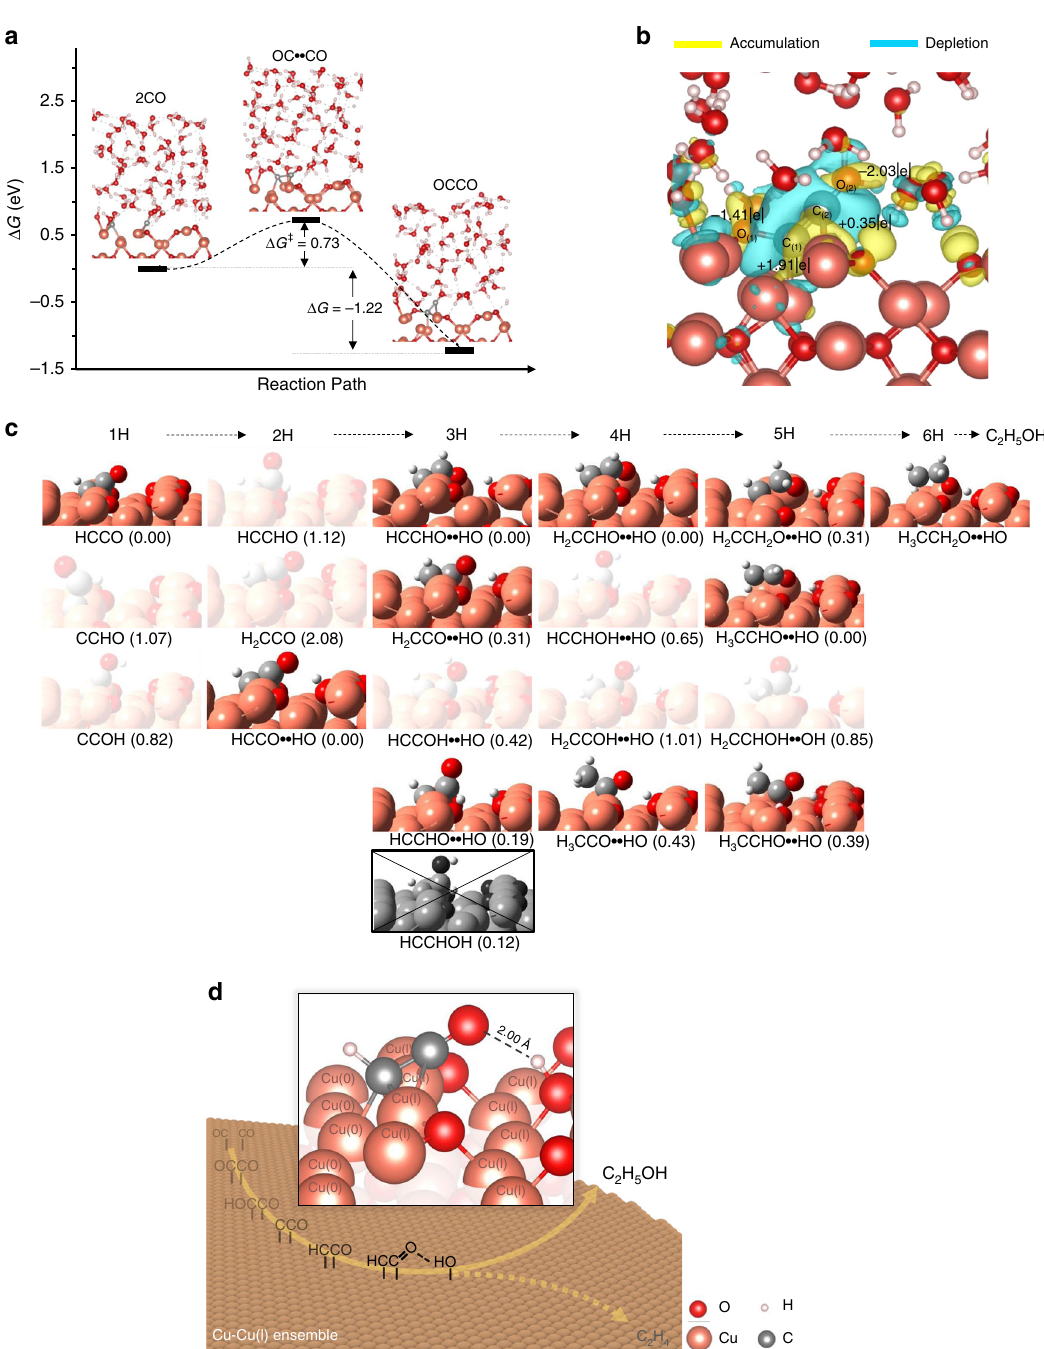
Fig. 4 DFT calculation results and proposed selectivity mechanism scheme. a The pro fi les of the potential energy surface for the dimerization of CO on Cu – Cu(I) ensembles. b The Bader chargers of the OCCO intermediates. c The accessible carbonyl-stabilized intermediates on the Cu – Cu(I) ensemble. The relative free energy in eV of each hydrogenation stage is denoted in the parentheses. d The schematic representations of the determined factor for the selective ethanol